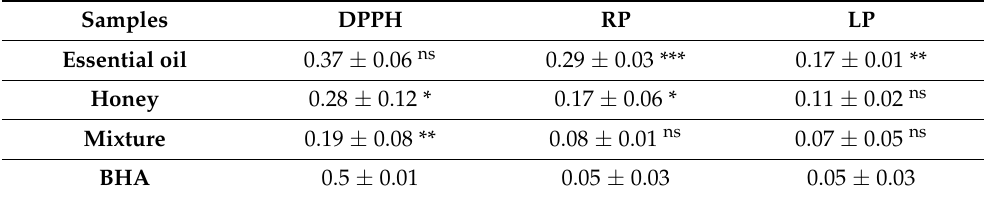
Table 3. The antioxidant activity of EGEO, E. globulus honey, and their mixture (IC 50 in µ g/mL). Samples